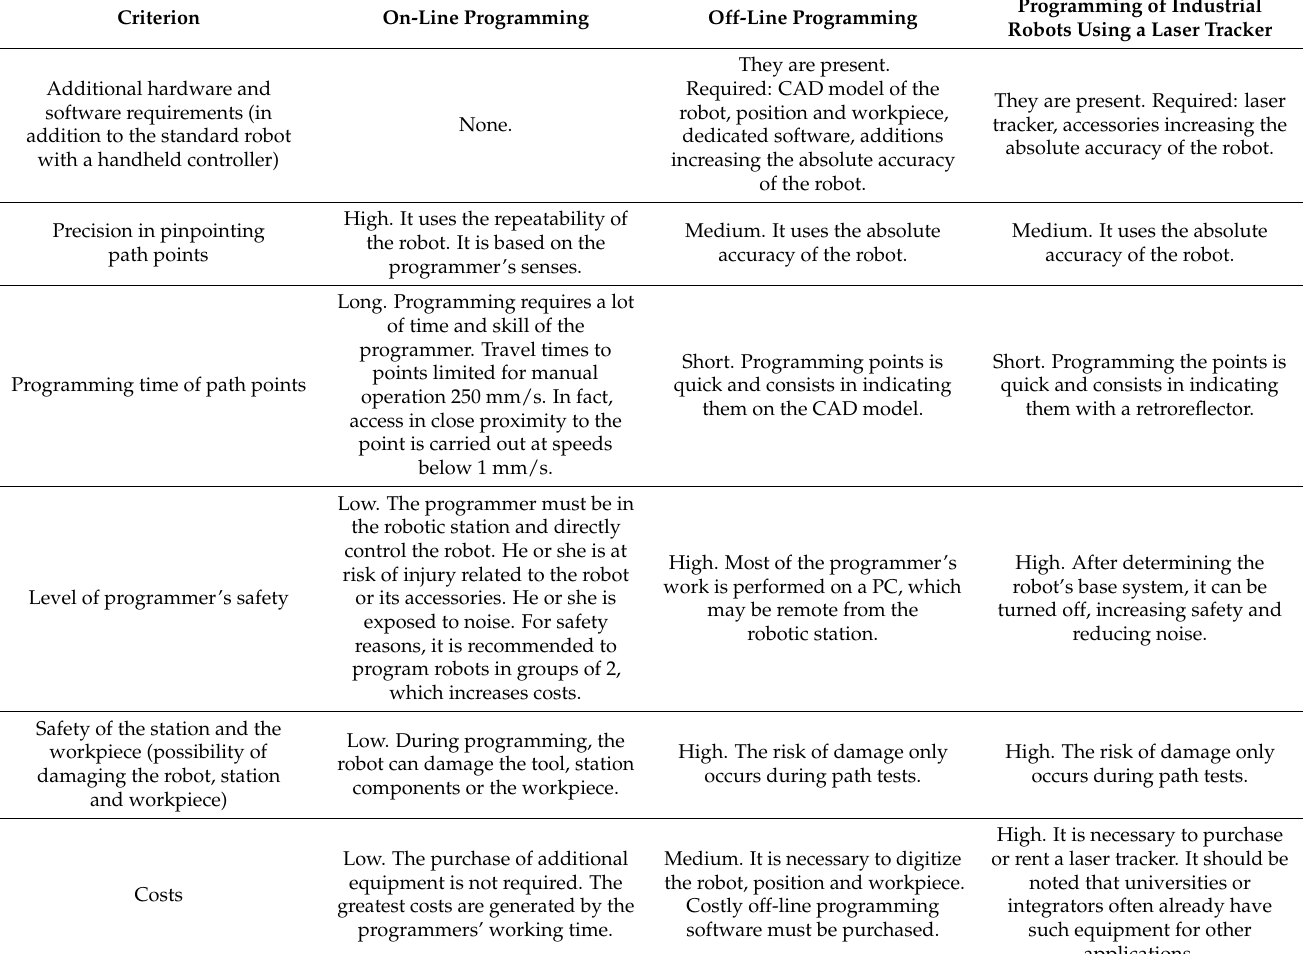
Table 4. Comparison of the robot programming